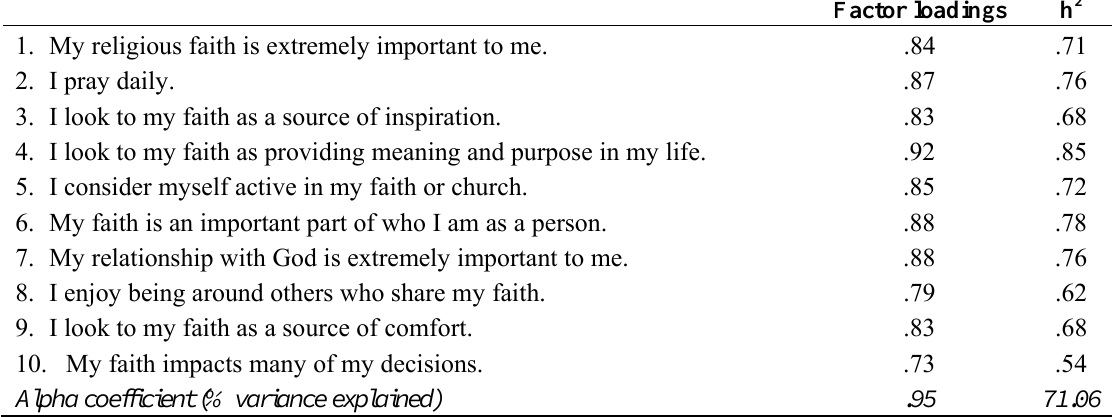
Table 3. Factor Loadings and Communalities for the Santa Clara Strength of Religious Faith